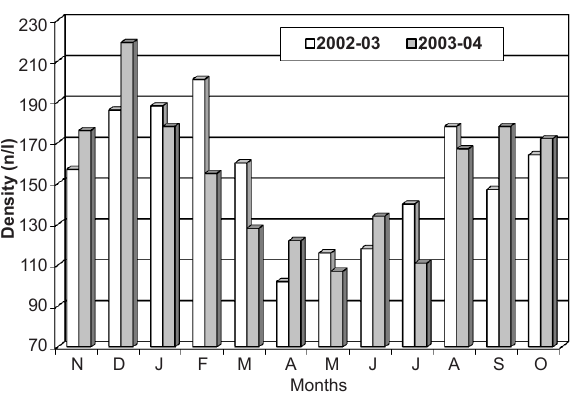
Figure 8. Monthly variations in abundance of phytoplankton of Waithou Pat